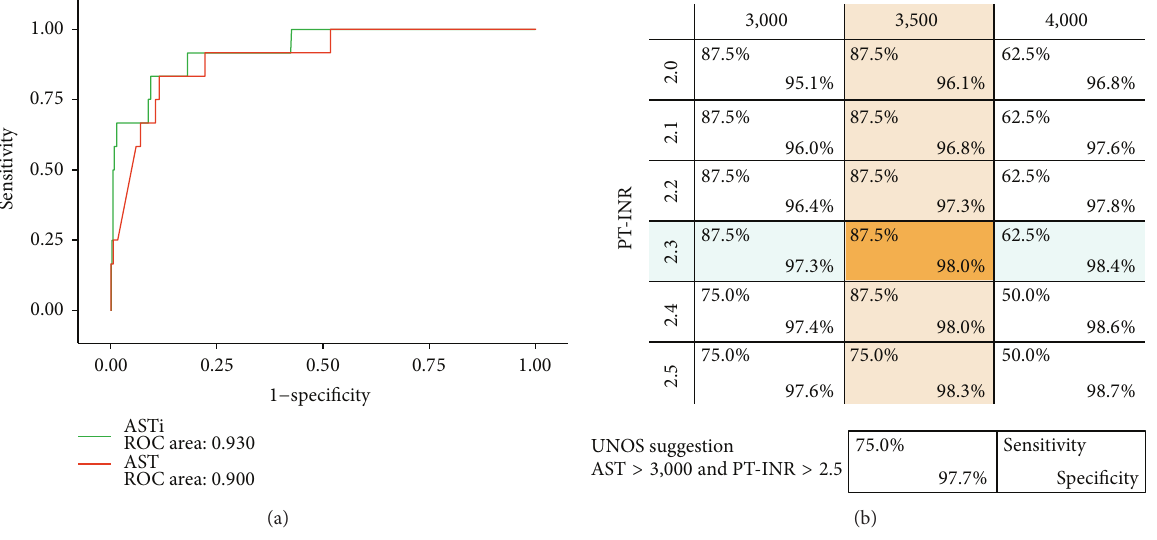
Table 2: Analyses of cases with different predictive results for PNF by conventional UNOS criteria and ASTi criteria. Conventional criteria ASTi criteria